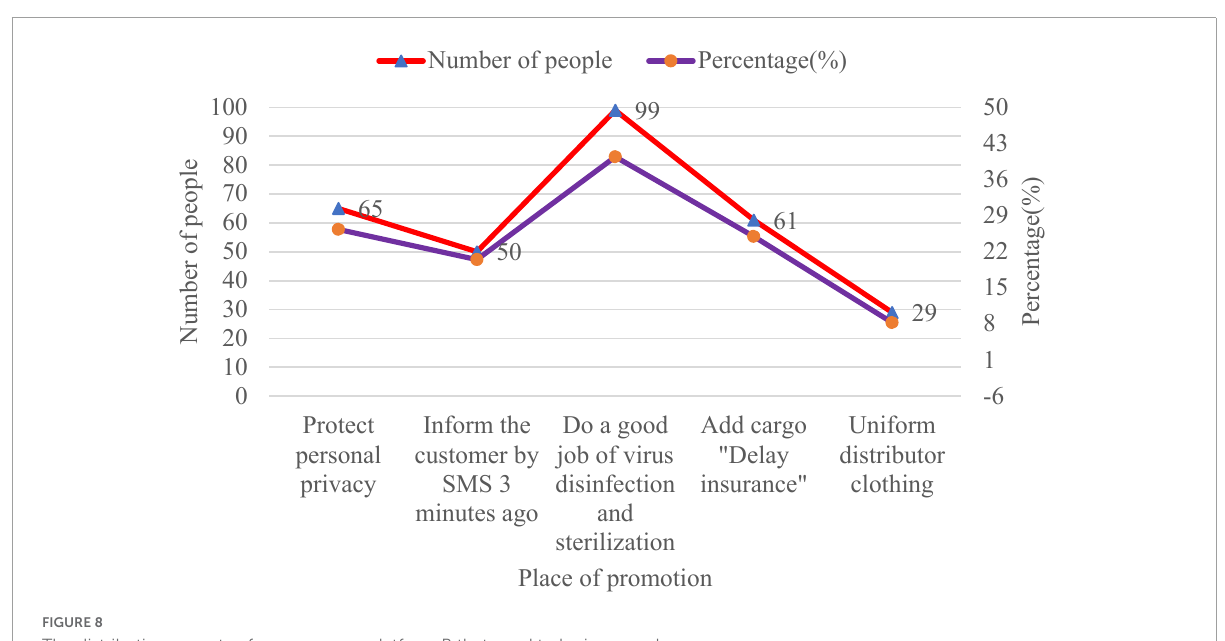
FIGURE7 Delivery timeliness of goods on e-commerce platform B.